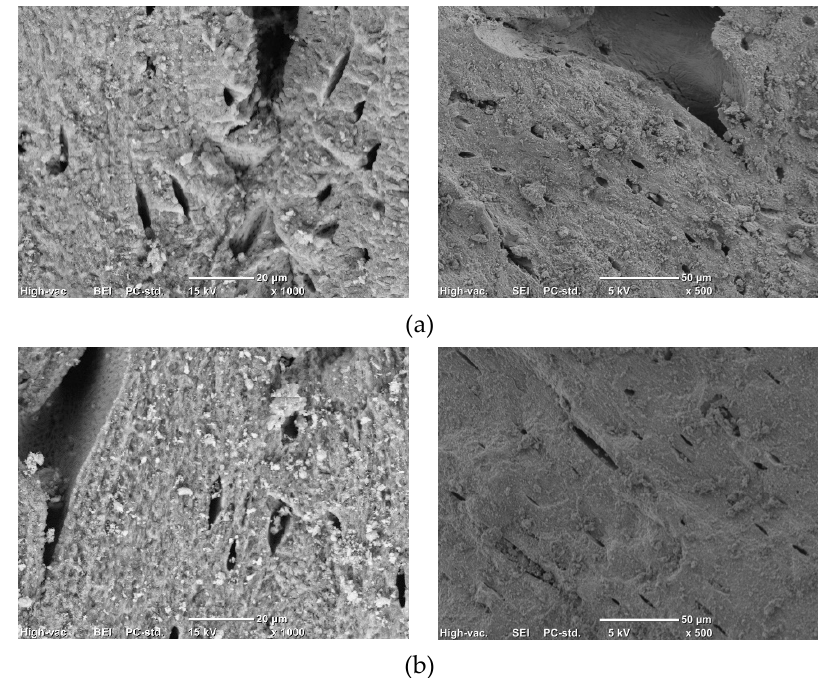
Figure 3. SEM images for ( a ) BC900 and ( b ) (BC/nTiO 2 ) P.